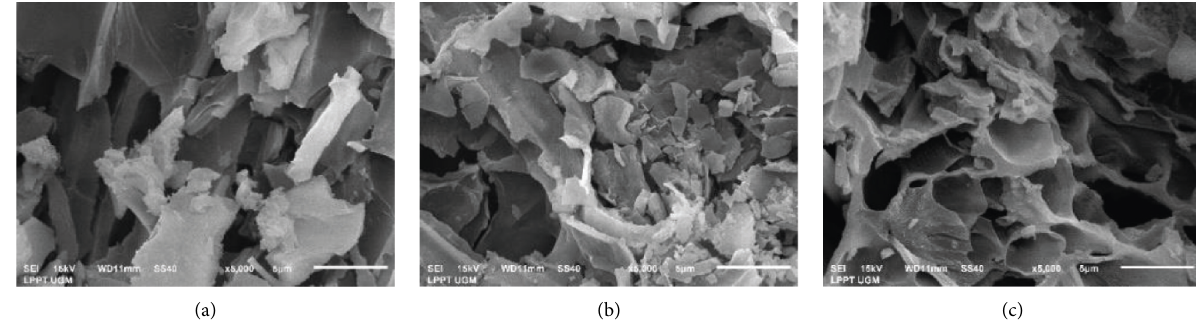
Figure 2: SEM test results of bamboo leaf biochar. (a) Pyrolysis temperature 400 ° C. (b) Pyrolysis temperature 450 ° C. (c) Pyrolysis temperature 500 °